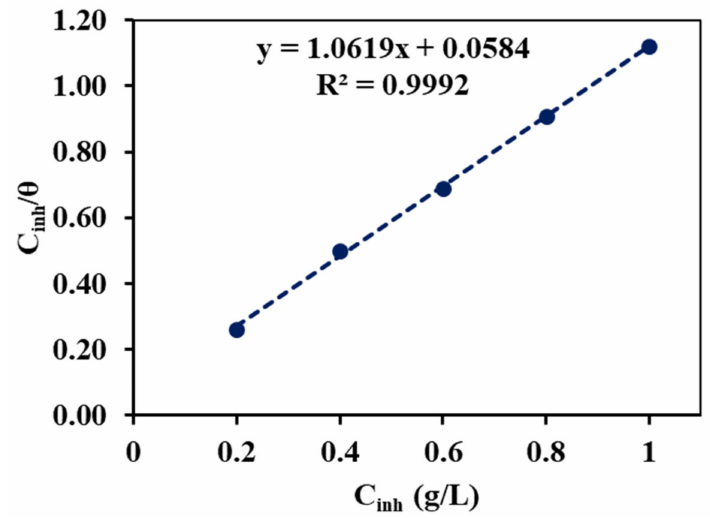
Figure 9. Langmuir adsorption isotherm plot for the MS in the 1 M H 2 SO 4 with different concentra- tions of the inhibitor.